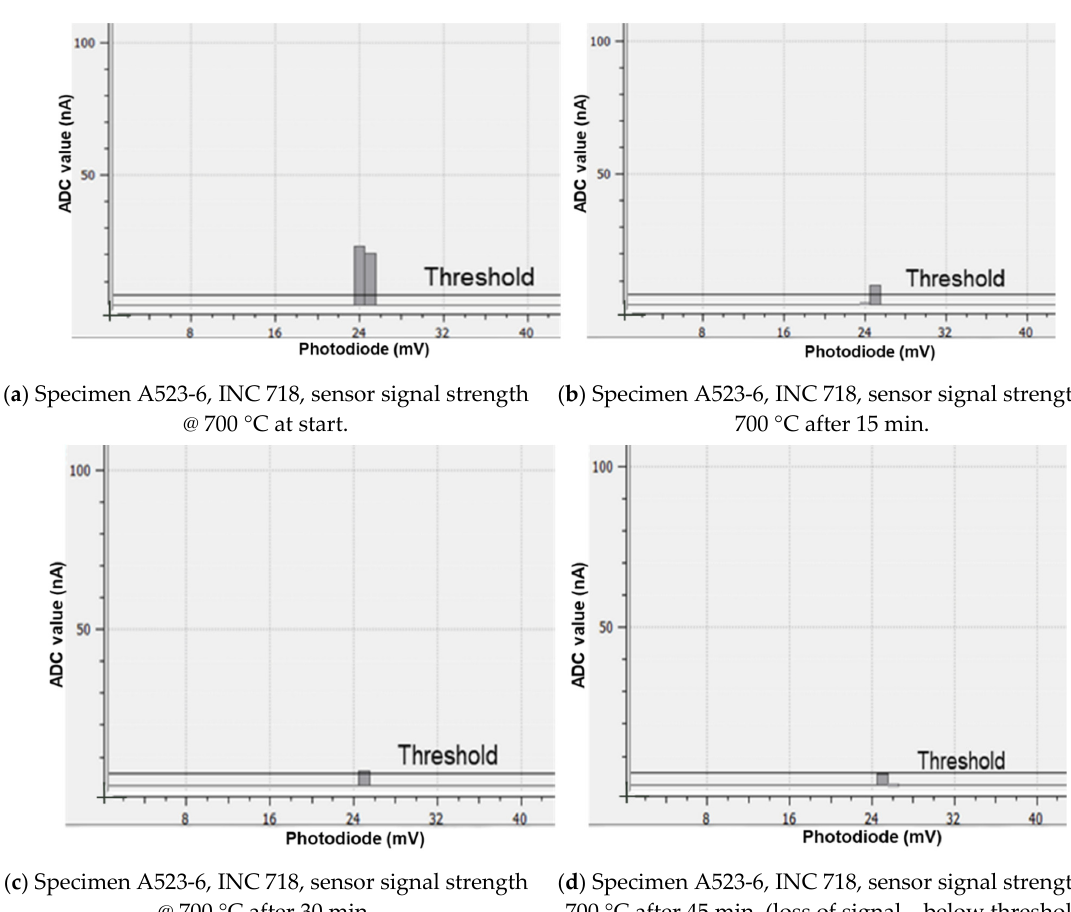
Figure 18. Specimen A523-6, INC 718, sensor signal strength @ 700 °C ( a ) at start, ( b ) after 15 min., ( c ) after 30 min., and ( d ) after 45 min.